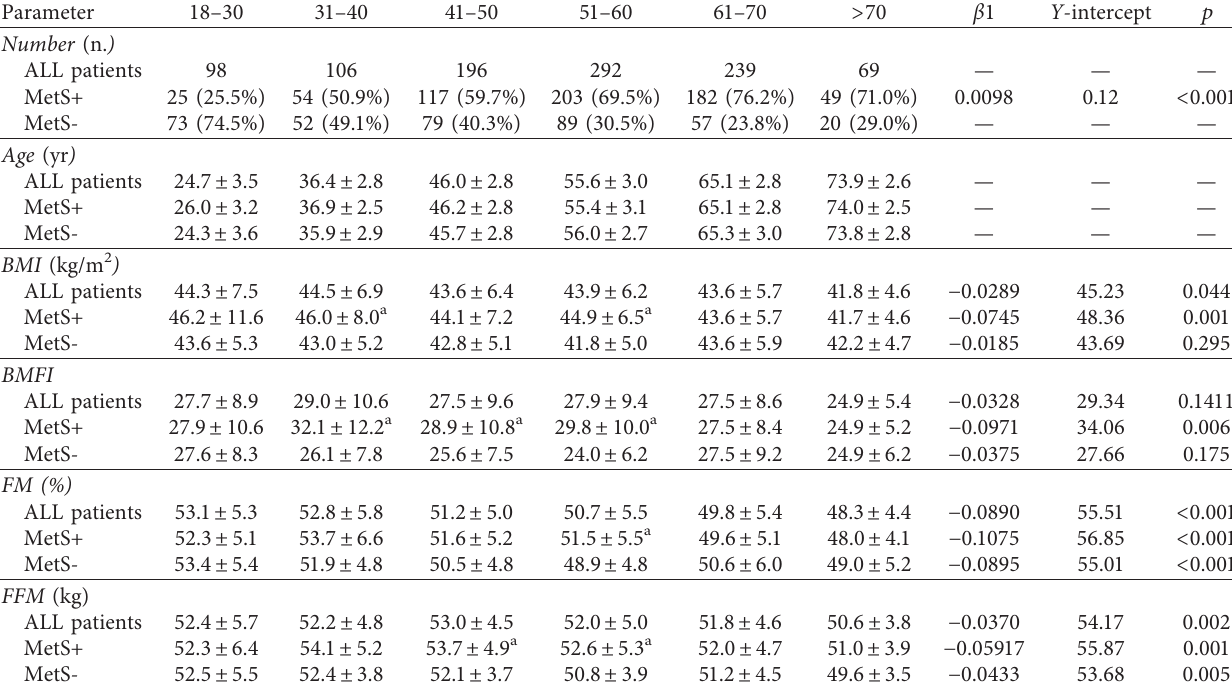
Table 1: Demographic characteristics and body composition in the entire obese population of our study and in the patients with or without metabolic syndrome, subdivided among age ranges. Parameter